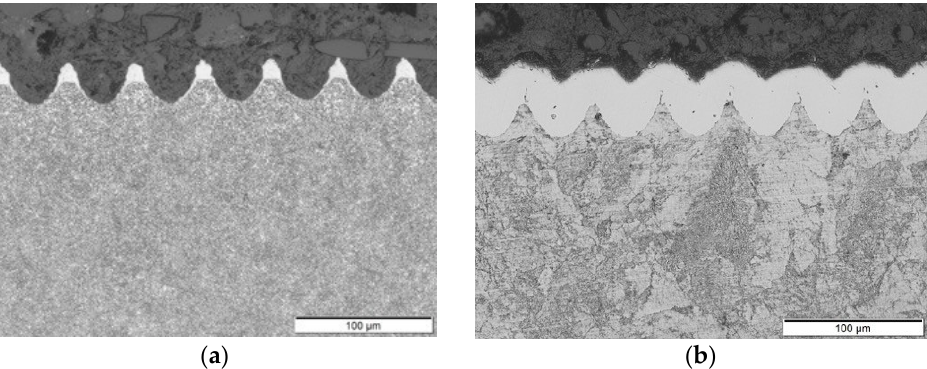
Figure 3. ( a ) LOM cross-section image of the laser-textured sample before hardening. ( b ) The image shows a cross-section of the sample after the TRD CrC hardening process. The sample in the images has a depth of craters ~30 µm and a spot-to-spot spacing ~50 µm.